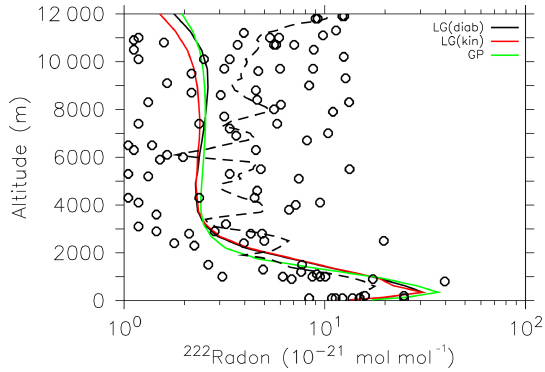
Figure 6. Vertical profiles of 222 Rn mixing ratio (10 − 21 molmol − 1 ) during the Moffett campaign. The thick dashed line is a spline interpolation of the scattered measurement data (circles) on the grid.